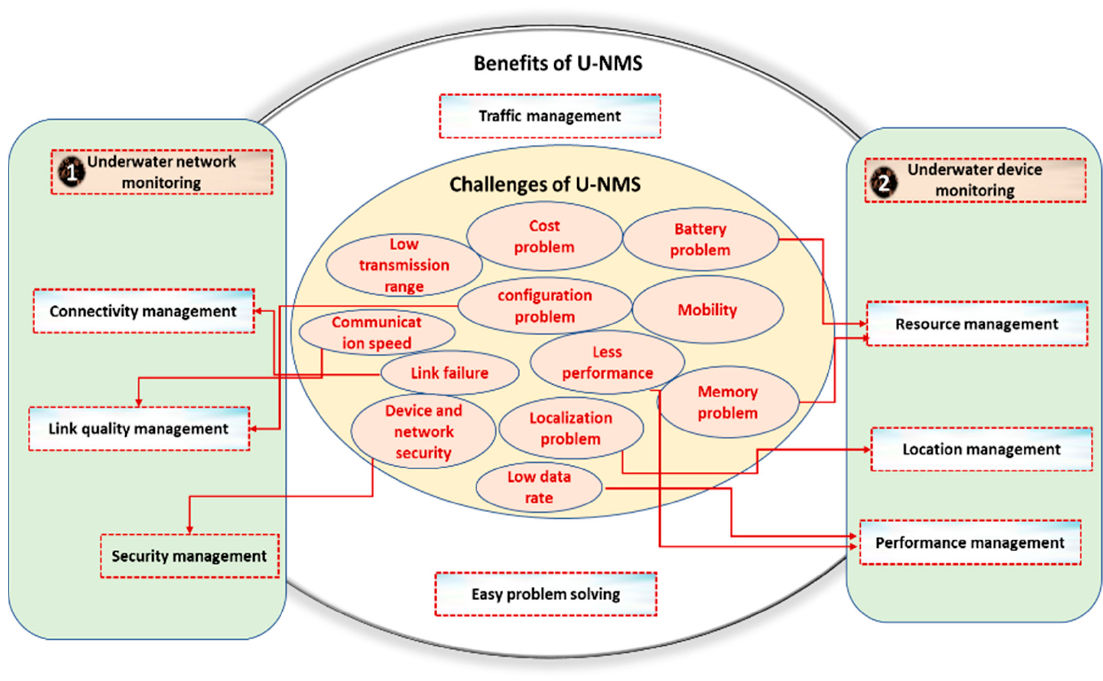
Figure 10. Benefits of using U-NMS.